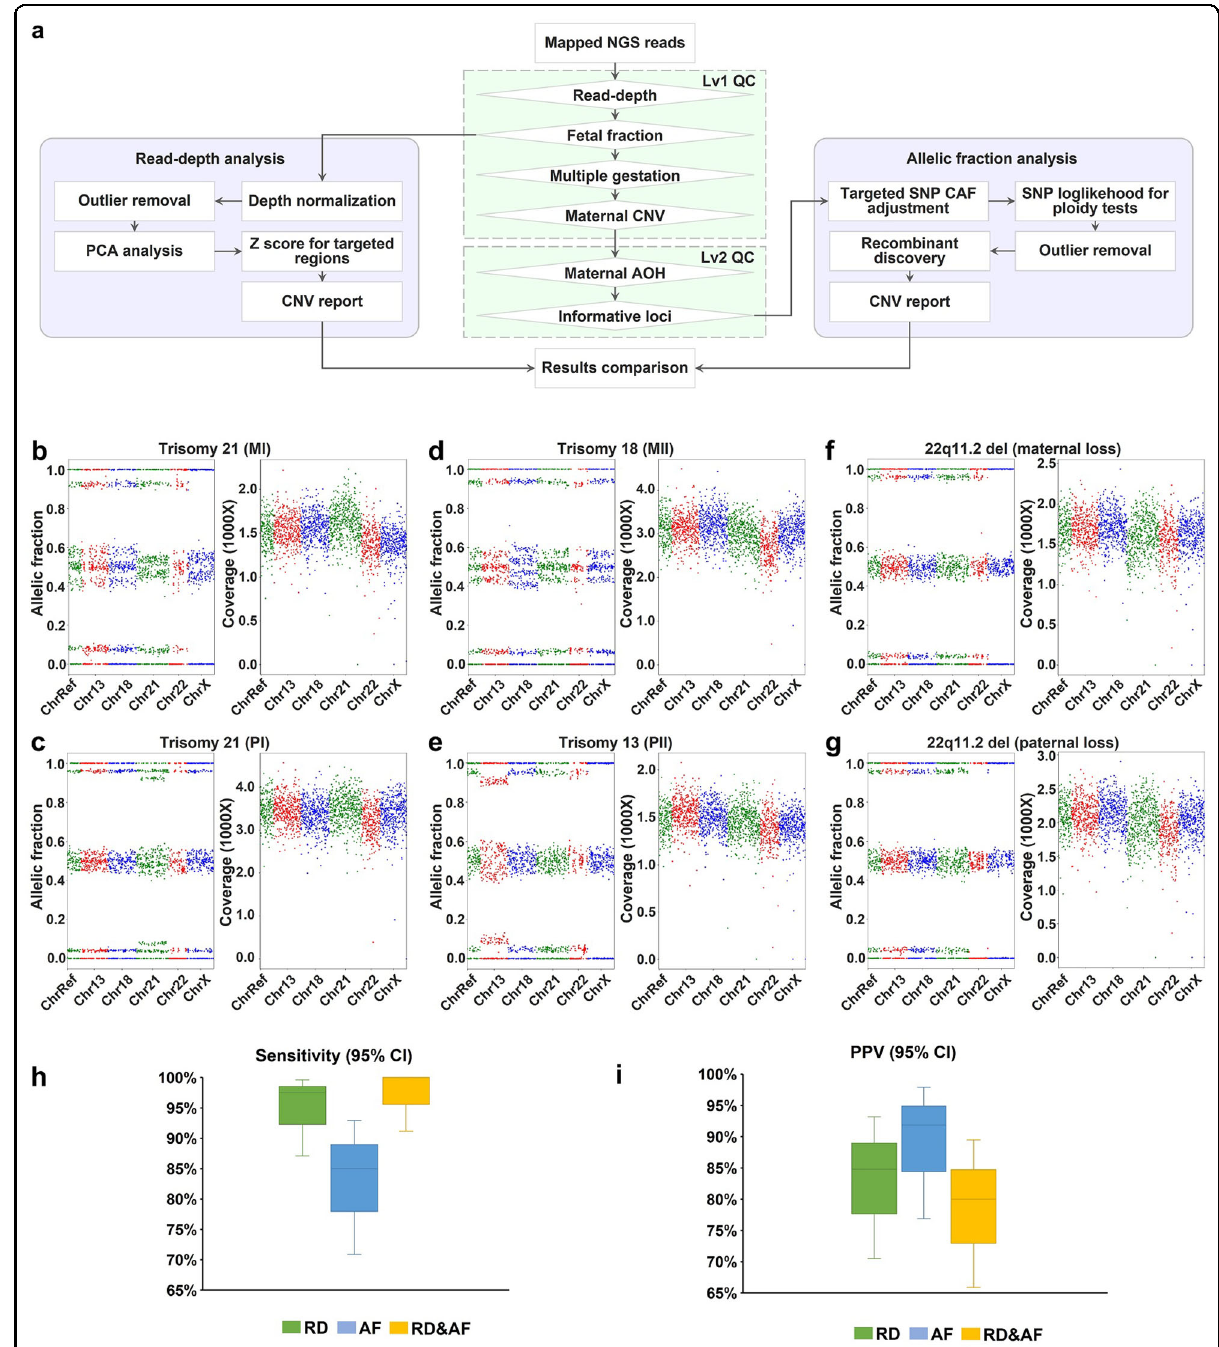
Fig. 2 (See legend on next